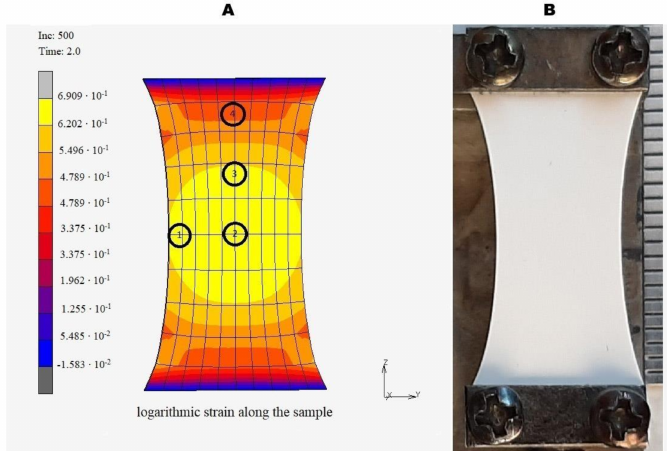
Figure 2. ( A ) A graphical representation of the sample deformation with control points. The numbers represent the regions of the matrix in the various positions of the extended matrix. ( B ) The device used for the elongation of matrices with the elongated